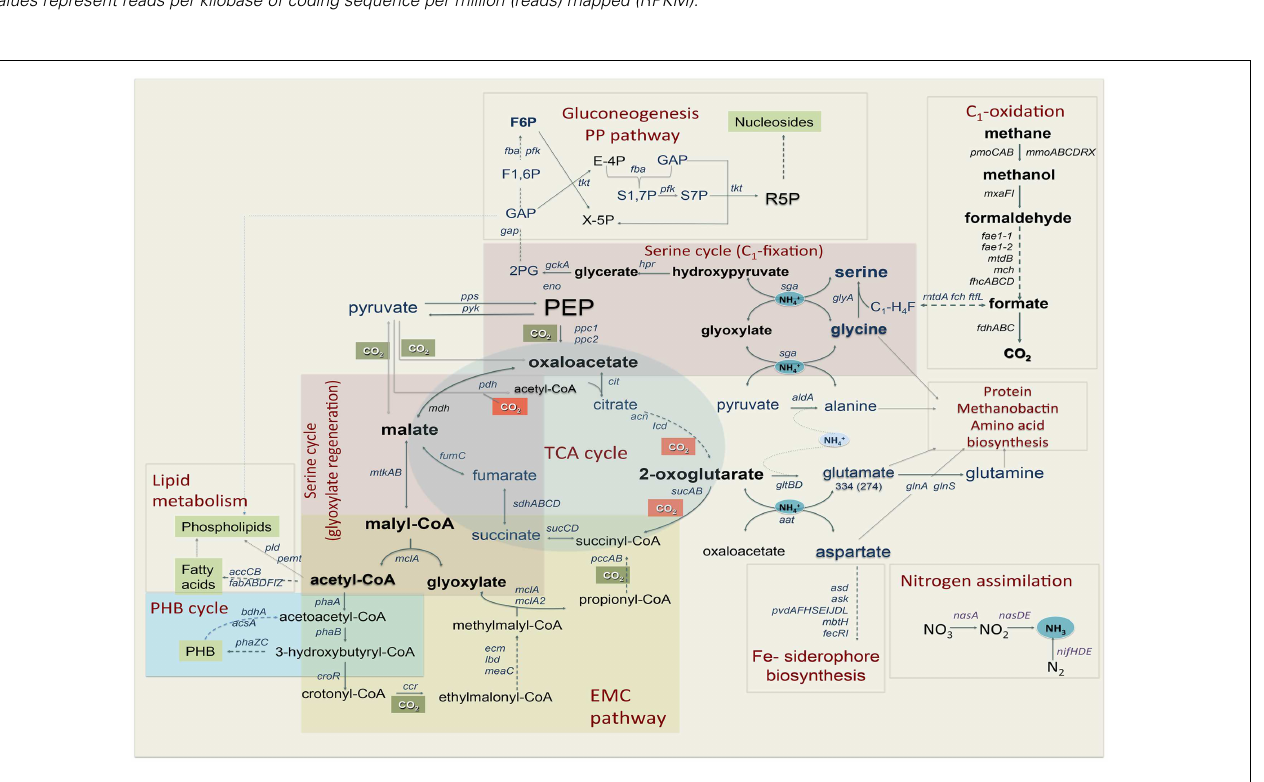
FIGURE 1 | Central metabolism of Methylosinus trichosporium OB3b grown on methane as sole source of energy and carbon as deduced from the genome sequences and transcriptomic studies. Font size of the gene name indicates the expression